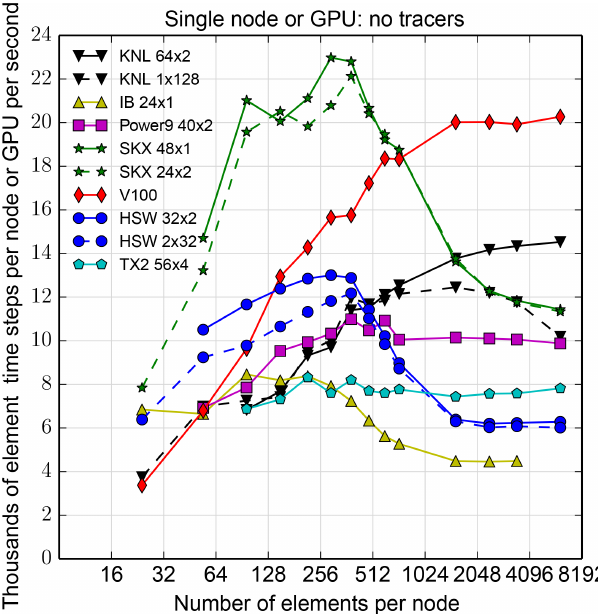
Figure 13. As Fig. 12, but with no